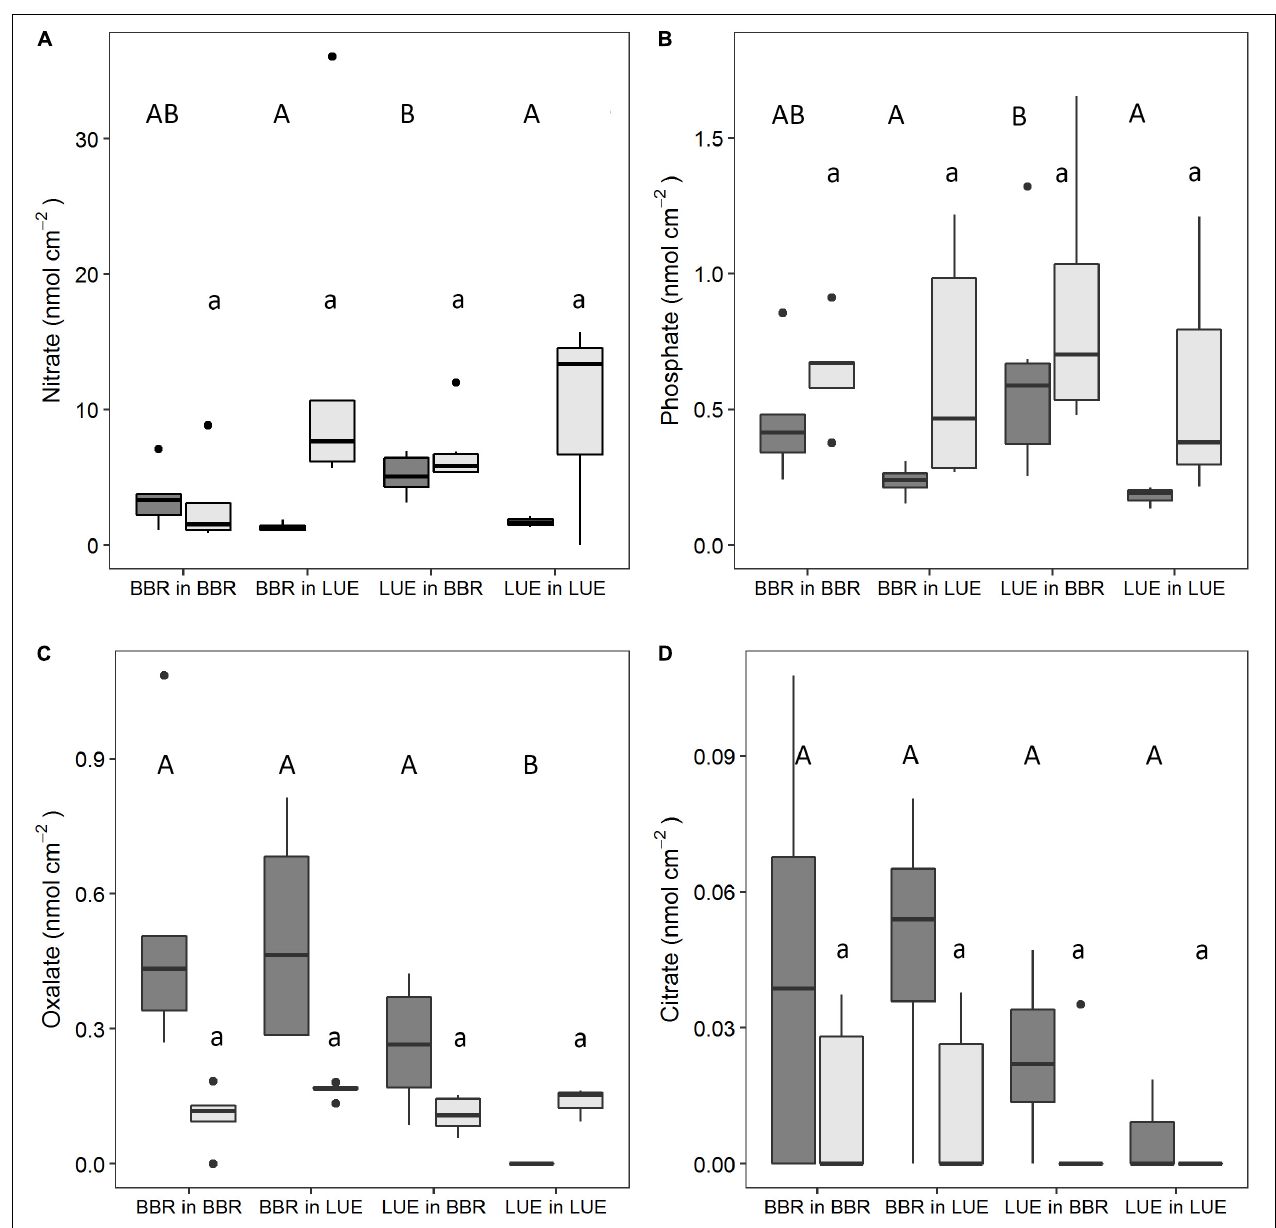
FIGURE 3 | Nitrate (A) , phosphate (B) , oxalate (C) , and citrate (D) collected with anion exchange membranes in the rhizosphere in a rhizobox experiment with beech ( Fagus sylvatica L.) saplings originating from the sites Bad Brückenau (BBR) and Unterlüss (LUE). The saplings were grown in material from the Bv horizon at BBR or from the Bh horizon at LUE. Shown are box plots based on values for replicate rhizoboxes in August of the first (dark gray) and second (light gray) season ( n = 5, except n = 3 for LUE in LUE); different letters indicate significant differences between means according to the Tukey post hoc test (uppercase letters, first growing season; lowercase letters, second growing